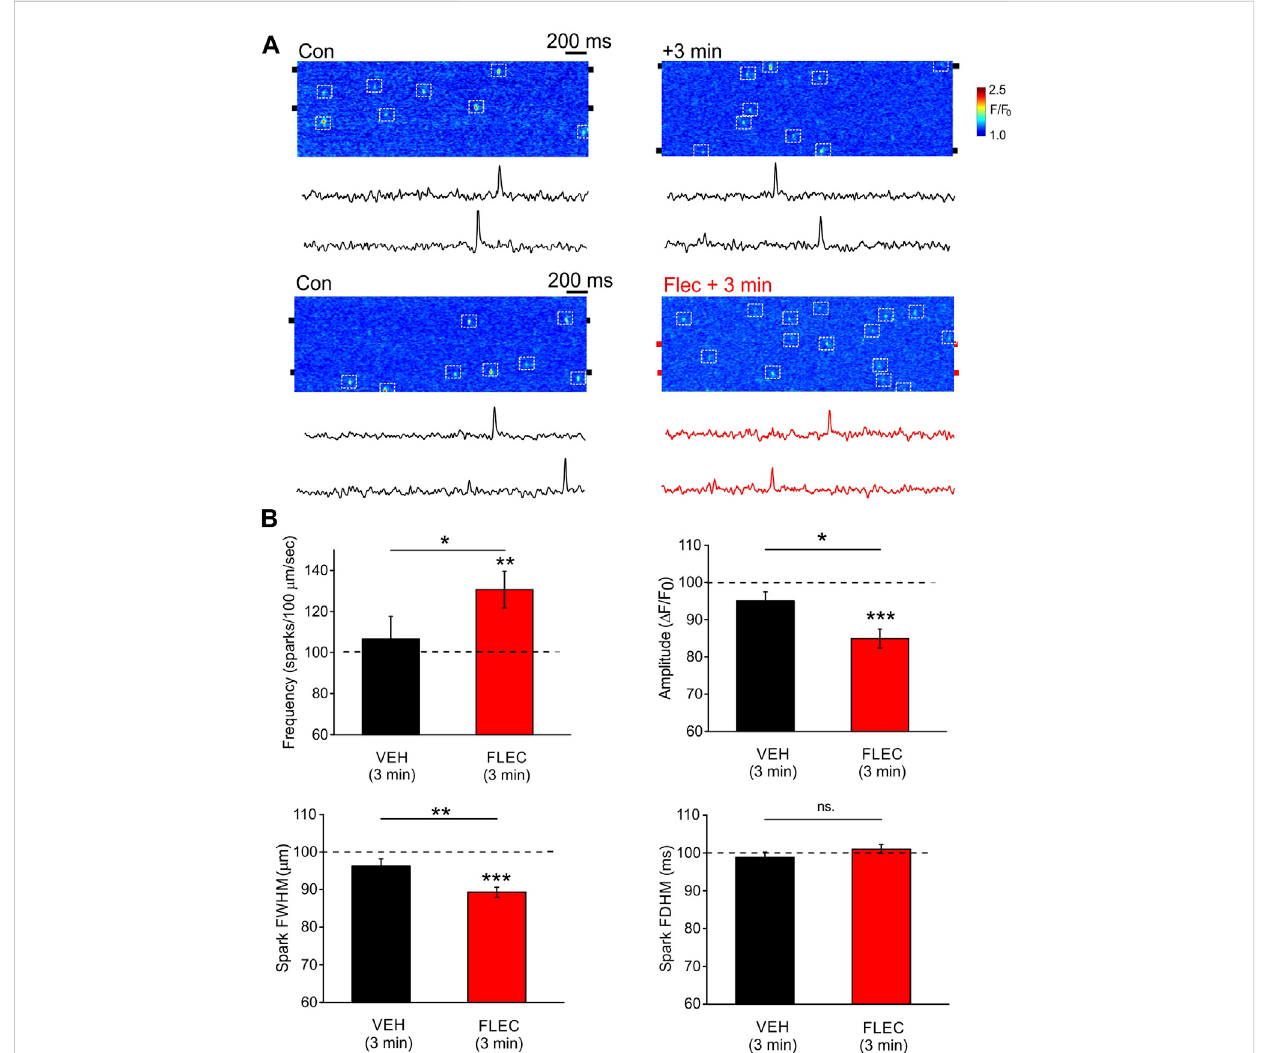
FIGURE 2 Effects of fl ecainide on Ca 2+ spark properties in permeabilized ARVM (A) , Representative line scan images and accompanying line pro fi les from two ARVMundercontrolconditionsandtheninthecorrespondingcell3after-minutes incubationwitheithervehicle( upper )or25 µM fl ecainide( lower ).The position of the box (2 pixels high) used to produce the line pro fi le was centered on the pairs of black ‘ tabs ’ shown on either side of each image. ( B) , Cumulative data showing the percentage change in spark frequency, amplitude, width and duration expressed relative to the time zero control (dotted line). Paired and unpaired Student ’ s t-tests as appropriate. * = p < 0.05; ** = p < 0.01; *** = p < 0.001. CON n = 11 (4), FLEC n = 31